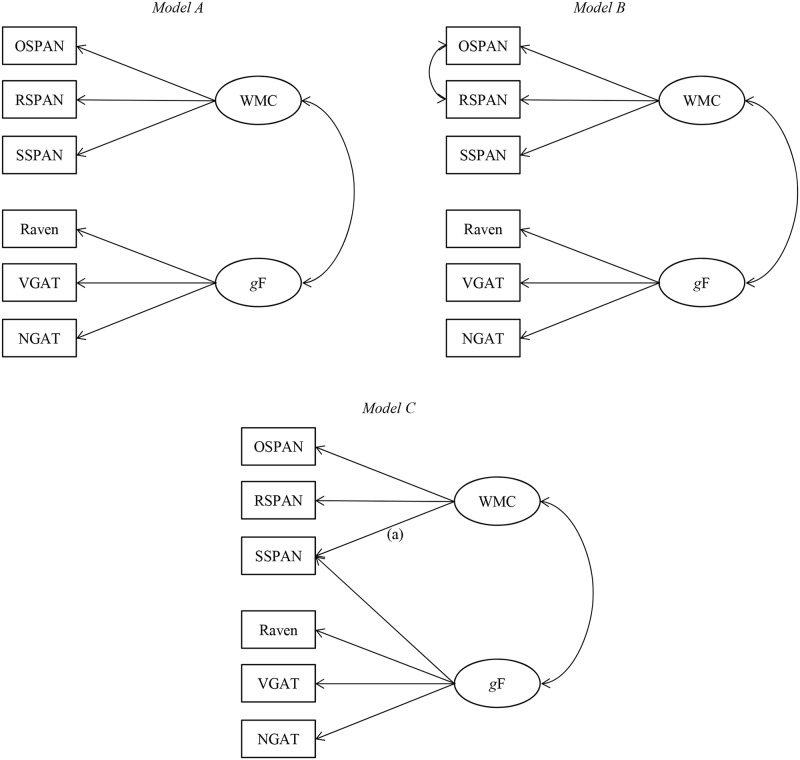
Schematic presentation of path models for the structural equation analysis of the relation between working memory capacity (WMC) and fluid intelligence (gF).Each model was tested for each type of WMC score and in subsamples with and without the 85% accuracy criterion on the processing component of span tasks. The paths leading from the constructs (circles) to the manifest variables (rectangles) represent the loadings of each measure on that construct. The double-headed paths between the WMC factor and the gF factor represent the correlation between the two constructs. The double-headed path between the OSPAN and RSPAN manifest variables in Model B represents the correlation between the residuals of these two measures. By exclusion of path (a) in Model C it was possible to test an additional model in which SSPAN is related only to the gF latent factor, but not with WMC factor. All paths and loadings in all models are significant at the p <.001 confidence level, for each type of WMC scores and in all analysed subsamples. OSPAN = operation span; RSPAN = reading span; SSPAN = symmetry span; Raven = Raven Advanced Progressive Matrices; VGAT = Verbal General Ability Test; NGAT = Numerical General Ability Test.